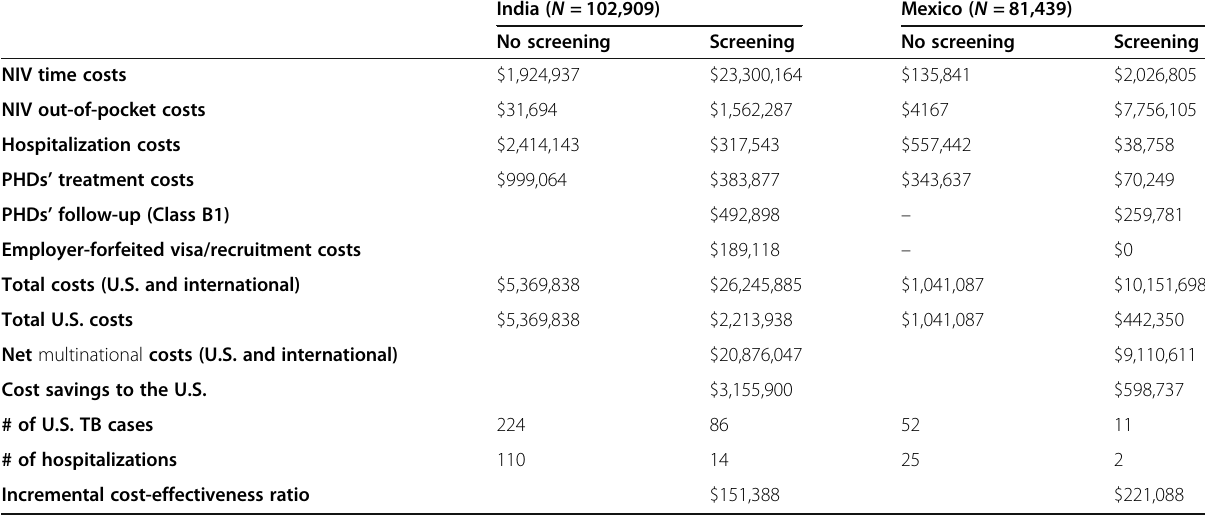
Table 3 Estimated total annual economic costs for tuberculosis screening of nonimmigrant visa applicants, by program and